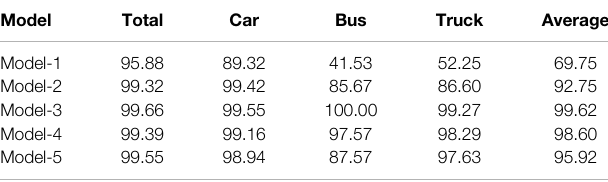
TABLE 4 | Vehicle counting accuracy of each model (%).